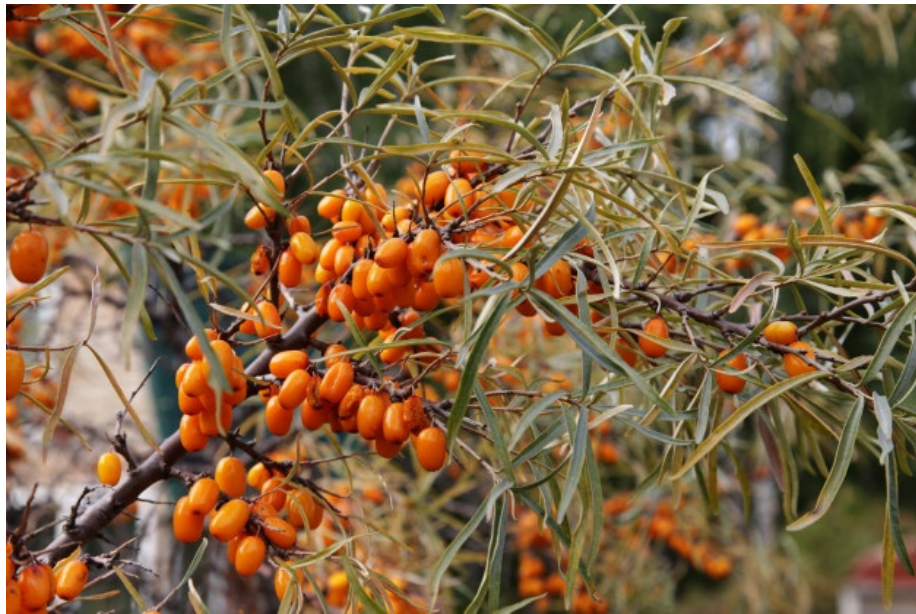
Figure 1. Sea buckthorn branch with berries [11].